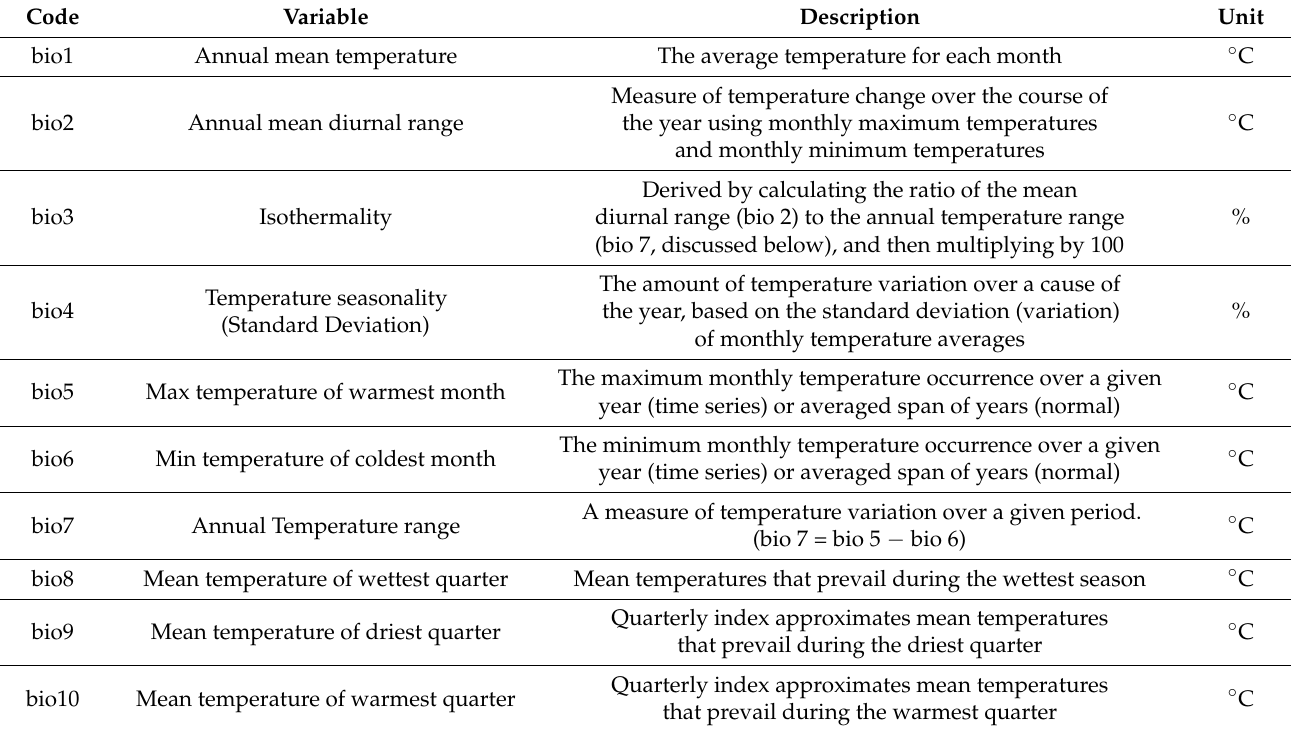
Table 1. Bioclimatic variables from WorldClim 2.0 used to predict the current and future distribution of two Sri Lankan bat